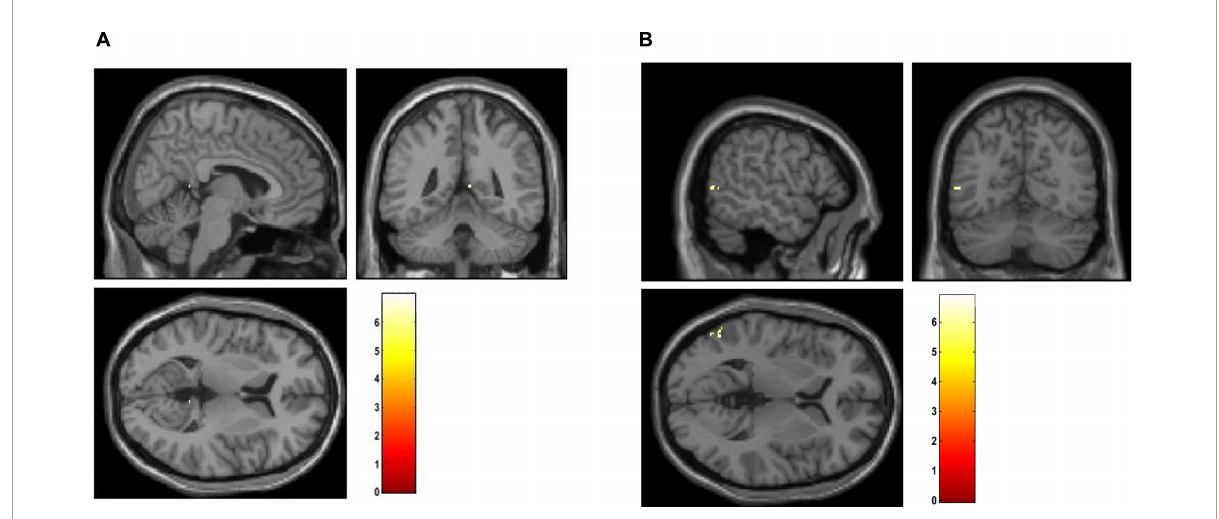
FIGURE5 Visualization of between-group comparison results using the mean lambda maps represented. Two sample t-test was applied with age, sex and smoking as covariates in (A) FEP > HC, and (B) CHR > HC. The corrected p -values (FWE < 0.05) are presented.